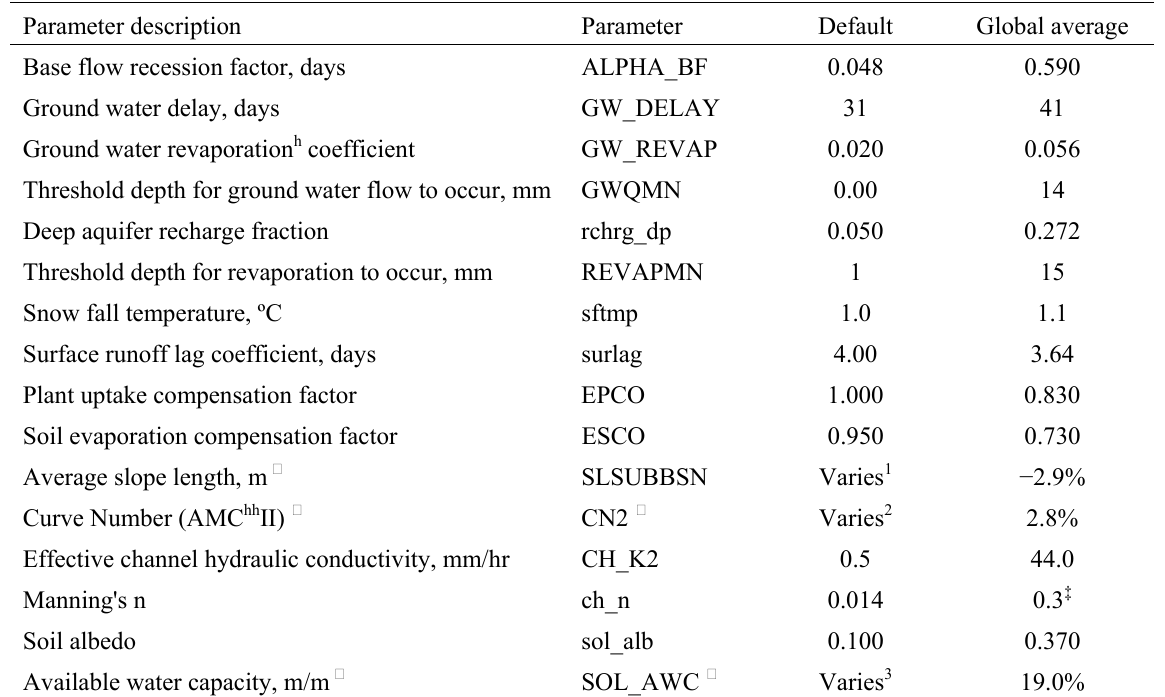
Table 3. Model parameter values obtained using global